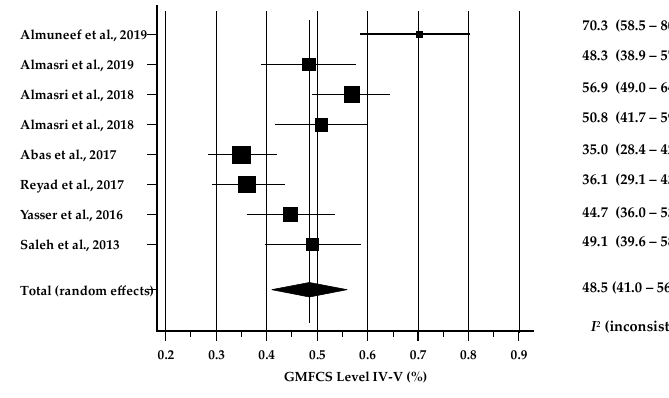
Figure 4. Forest plot (to the left) shows the pooled estimates % of GMFCS level IV-V among children and adolescents with CP in ASCs [29,39–42,47–49]. Assessment of publication bias by Funnel plot (to the right) shows individual study estimates against corresponding standard errors (Kendall’s Tau = − 0.5714, p = 0.0478). I 2 suggests considerable heterogeneity between studies.